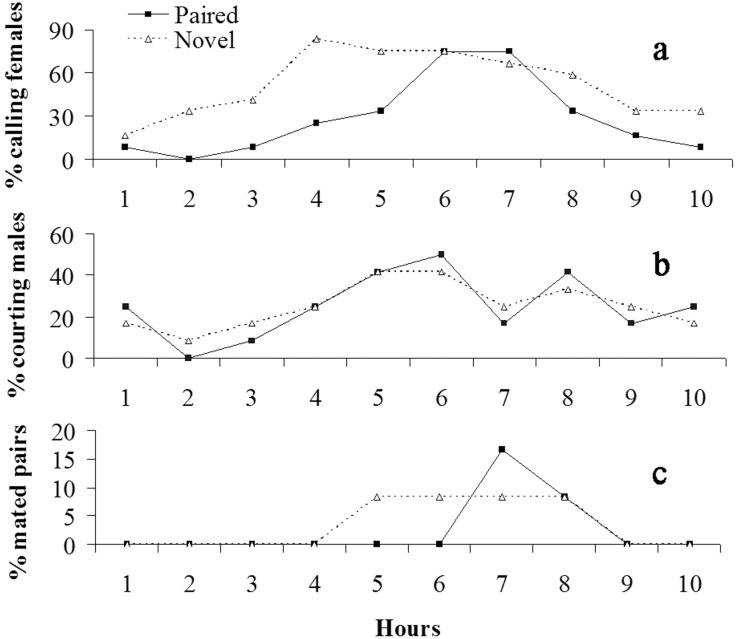
Hourly percentages of calling females (a), courting males (b) and mated pairs (c) in Novel and Paired treatments in S. litura.